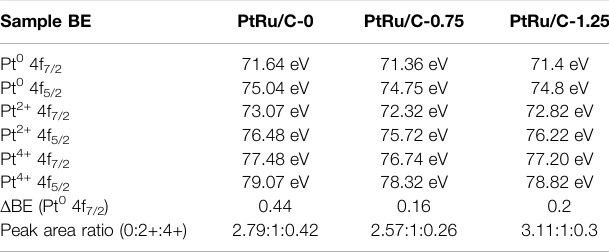
TABLE 1 | The binding energy of the peaks of different valence states of the Pt element of the samples. Sample